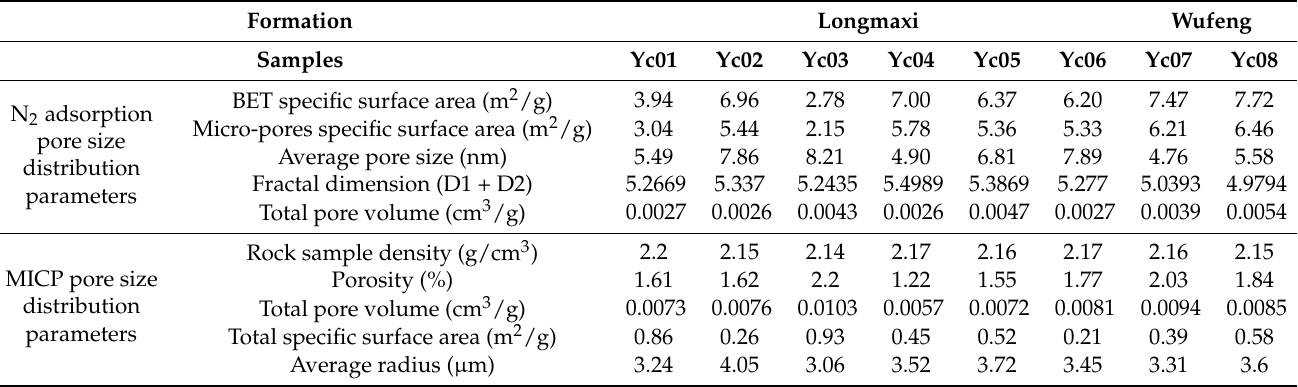
Table 2. Data for parameters associated with pores in shale samples obtained from N 2 adsorption and MICP